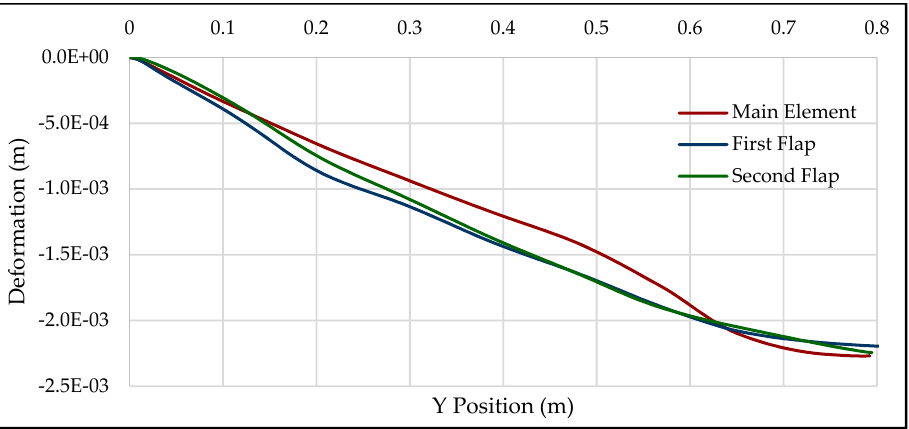
Figure 14. Z-deformation in the trailing edge of the Formula One 2022 front wing.